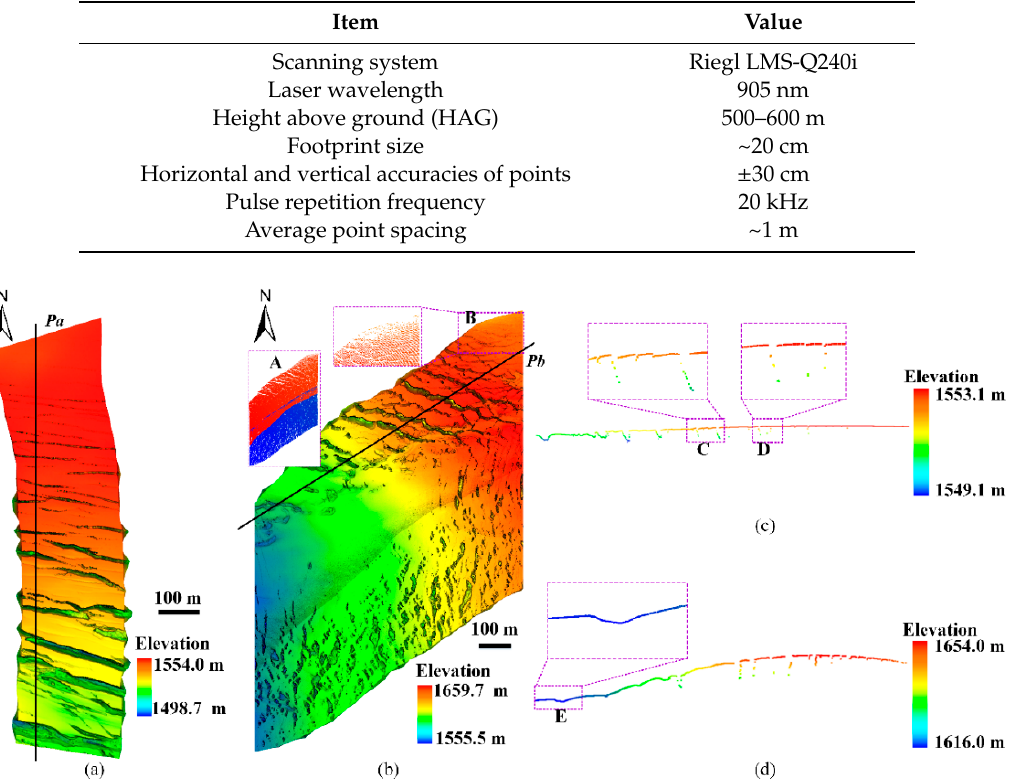
Figure 2. Point clouds of the two sites. ( a ) Point clouds of the first site. ( b ) Point clouds of the second site. ( c ) Profile of Pa in subgraph ( a ). ( d ) Profile of Pb in subgraph ( b ).